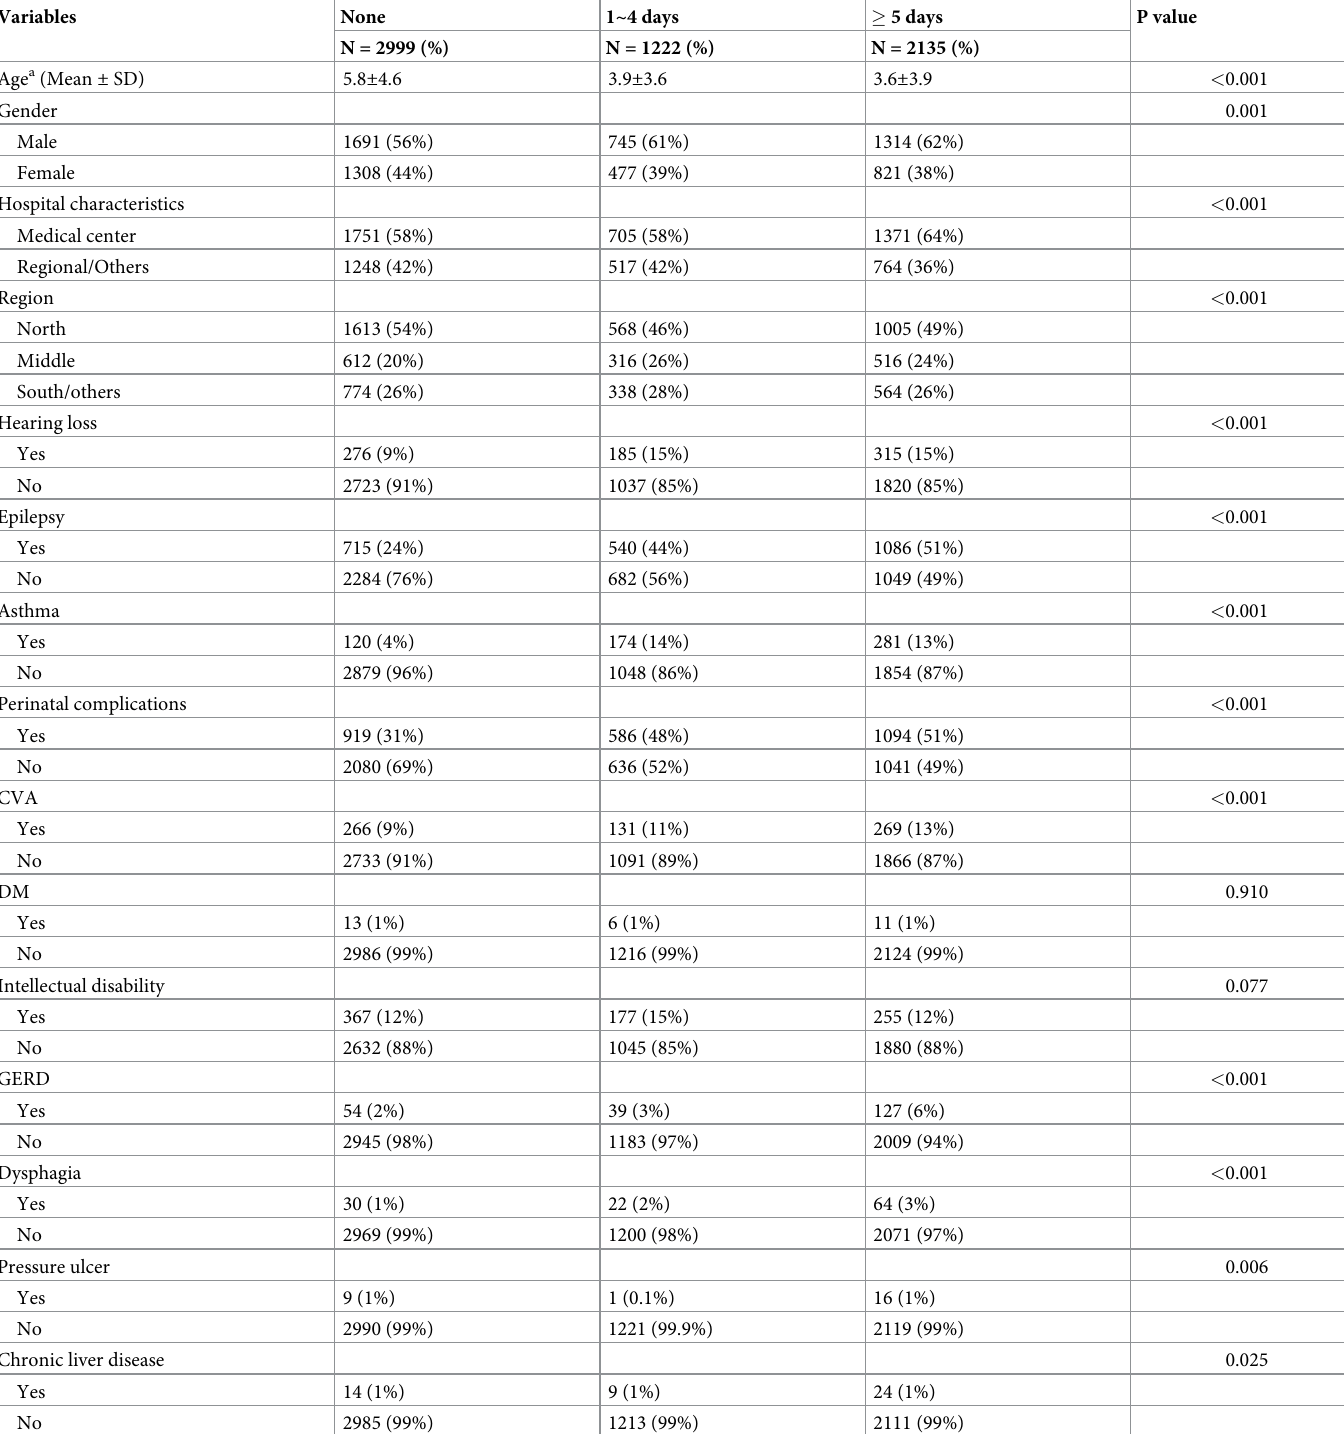
Table 1. Baseline characteristics of children and young people with severe cerebral palsy according to subgroups of pneumonia, n =